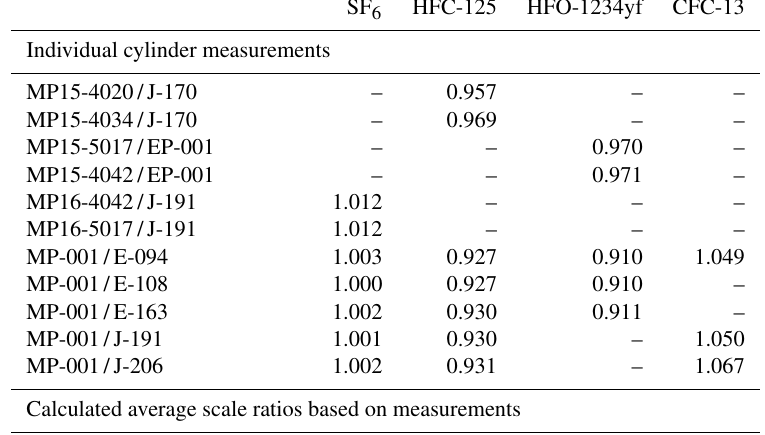
Table 6. Scale comparison: individual cylinder measurement results and calculated average scale ratios. All measurements have been per- formed by Medusa GC-MS at Empa Laboratories (see main text). We provide as well for documentation the known scale conversion factors used in this study: a Krummel et al. (2017), b Simmonds et al. (2017), c Christina M. Harth and Ray F. Weiss (personal communication,